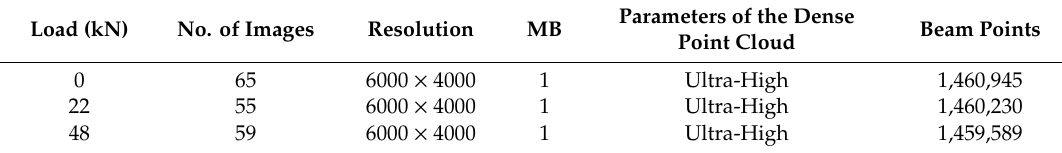
Table 10. Data and processing parameters of the CRP surveys beam#1 LC2 EOS M3.